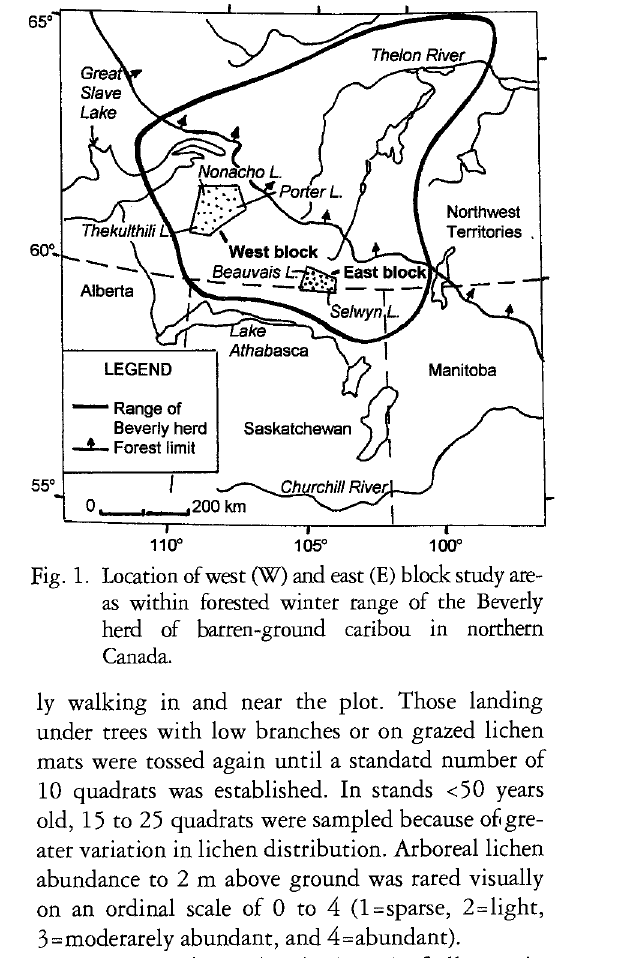
Fig. 1. Location of west (W) and east (E) block study are as within forested winter range of rhe Beverly herd of barren-ground caribou in northern Canada. ly walking in and near the plot. Those